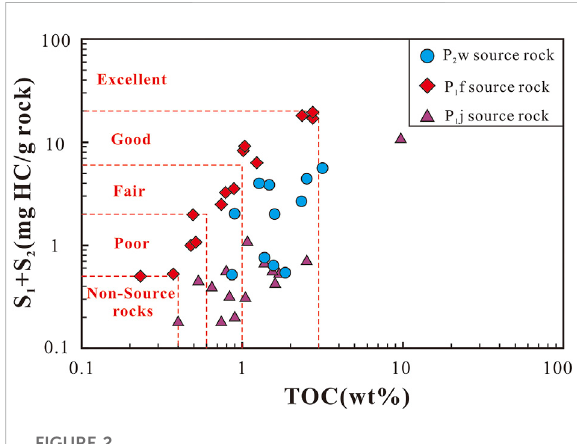
FIGURE 2 Plotofthegeneticpotential(S 1 +S 2 )versusTOCfromP 2 w,P 1 f, and P 1 j source rock